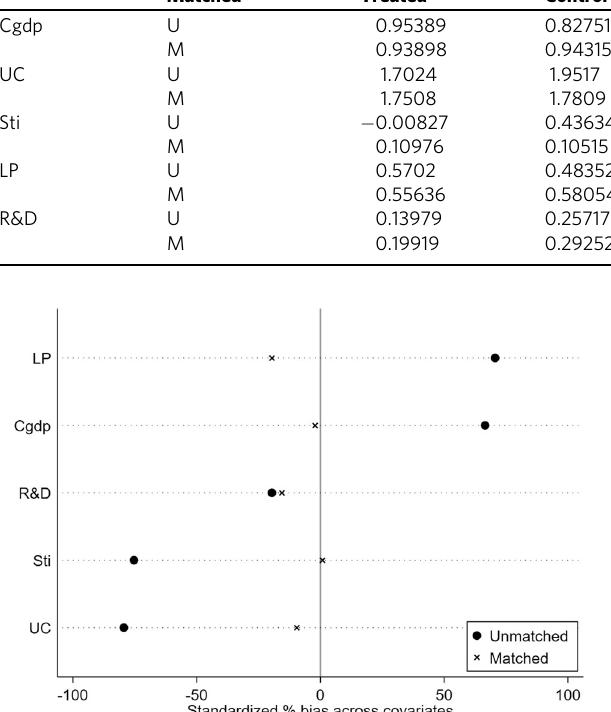
Fig. 5 In fl uence of the B&R policy on the GD level of construction enterprises — propensity score matching balance. The equilibrium of each variable before matching (solid black dots), the equilibrium of each variable after matching (x dots), and the equilibrium point (solid black line) are shown. Table 5 Impact of the B&R policy on the level of GD of construction enterprises —